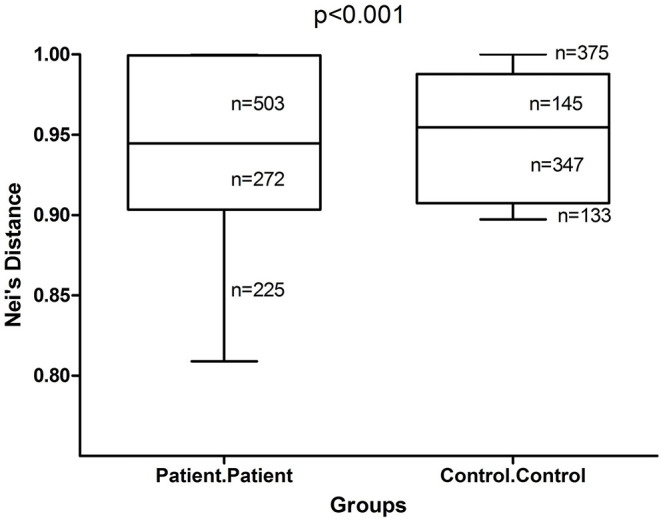
Box and whisker plots of Nei's distance in adult AD patients and healthy controls. Inter-individual variability among adult AD patients and healthy controls were measured by Nei's distance for 1,000 pairs of randomly sampled individuals from each group. The difference in the distribution of these pair-wise distances was tested for significance by Kolmogorov-Smirnov test. The Nei's distance was found to be significantly higher (p < 0.001) among healthy controls than among patients.